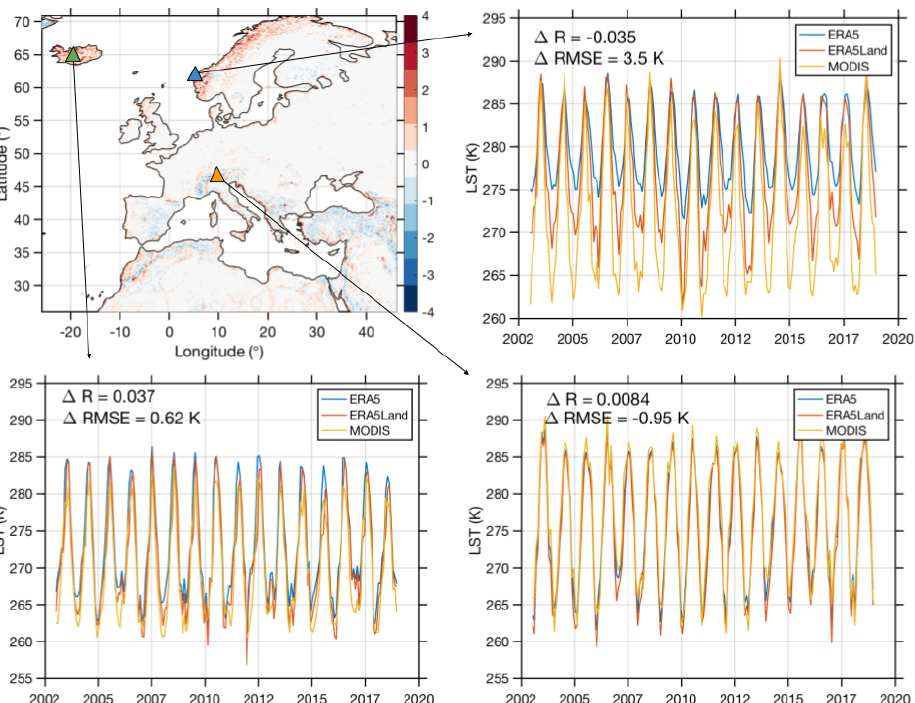
Figure 20. Map of RMSE differences ( (cid:49) RMSE (K)) between ERA5 and ERA5-Land with respect to the MODIS LST average ensemble for the time period 2003–2018. Red values denote lower RMSE of ERA5-Land with respect to the observational record. Time series of ERA5, ERA5-Land, and MODIS time series at selected pixels: coast of Norway (61.6 ◦ N, 5.3 ◦ E), the Alps (47.4 ◦ N, 11.15 ◦ E), and Iceland (64.5 ◦ N, 20.26 ◦ W). The differences in RMSE ( (cid:49) RMSE) and R ( (cid:49)R ) between ERA5 and ERA5-Land with respect to MODIS LST at each location are